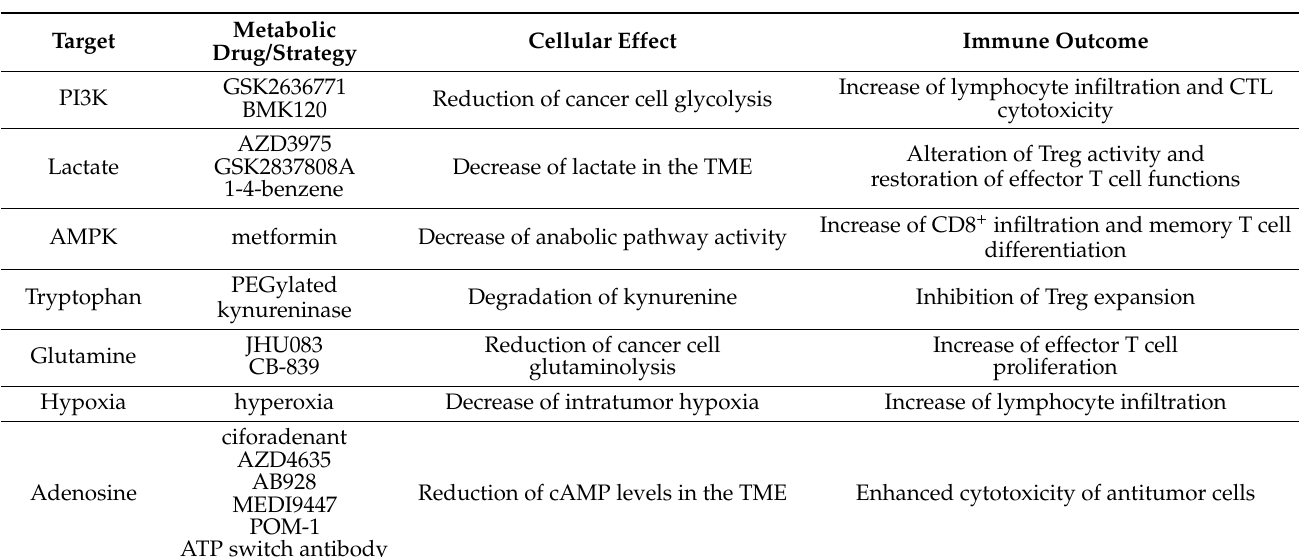
Table 1. Nonexhaustive suggestions of potential metabolic targets that improve the antitumor immune response when associated with immune checkpoint blockades. AMPK: AMP-activated protein kinase; cAMP: cyclic adenosine monophosphate; CTL: cytotoxic T lymphocyte; PI3K: phosphoinositide 3-kinase; TME: tumor microenvironment; Treg: T regulatory